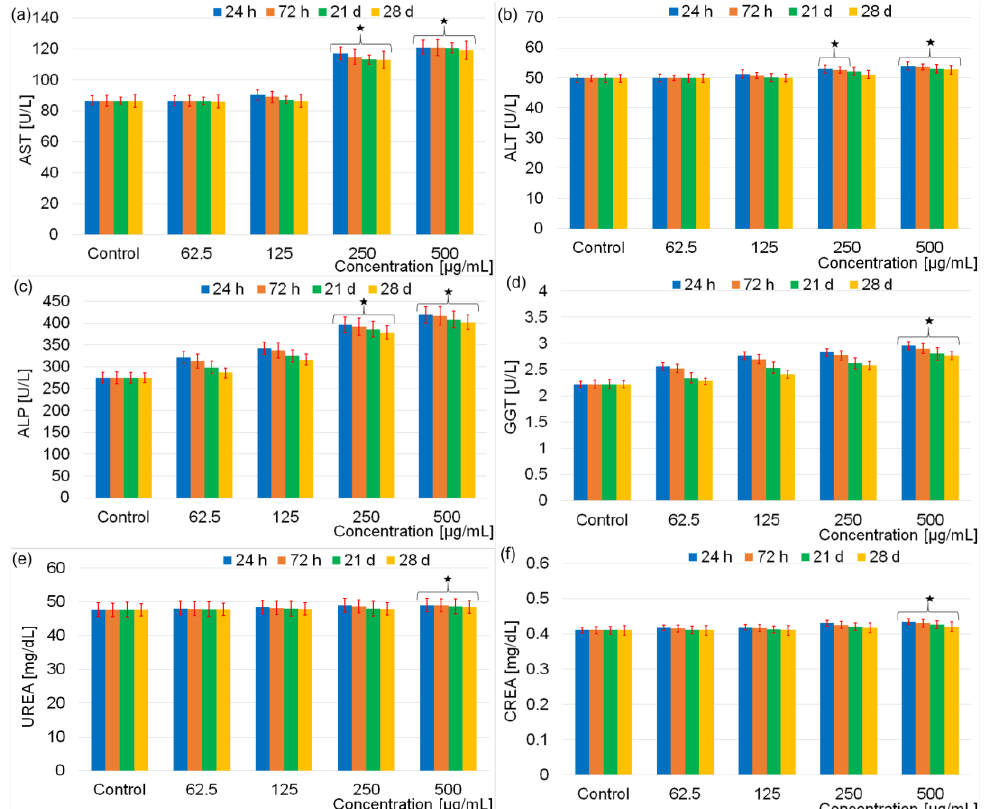
Figure 7. The biochemical results for rats exposed to different doses (62.5–500 µ g/mL) containing DIO-AMF at different time intervals as follows aspartate transaminase (AST) ( a ), alanine transaminase (ALT) ( b ), alkaline phosphatase (ALP) ( c ), γ -glutamyl transpeptidase (GGT) ( d ), urea (UREA) ( e ) creatinine (CREA) ( f ). (* p <